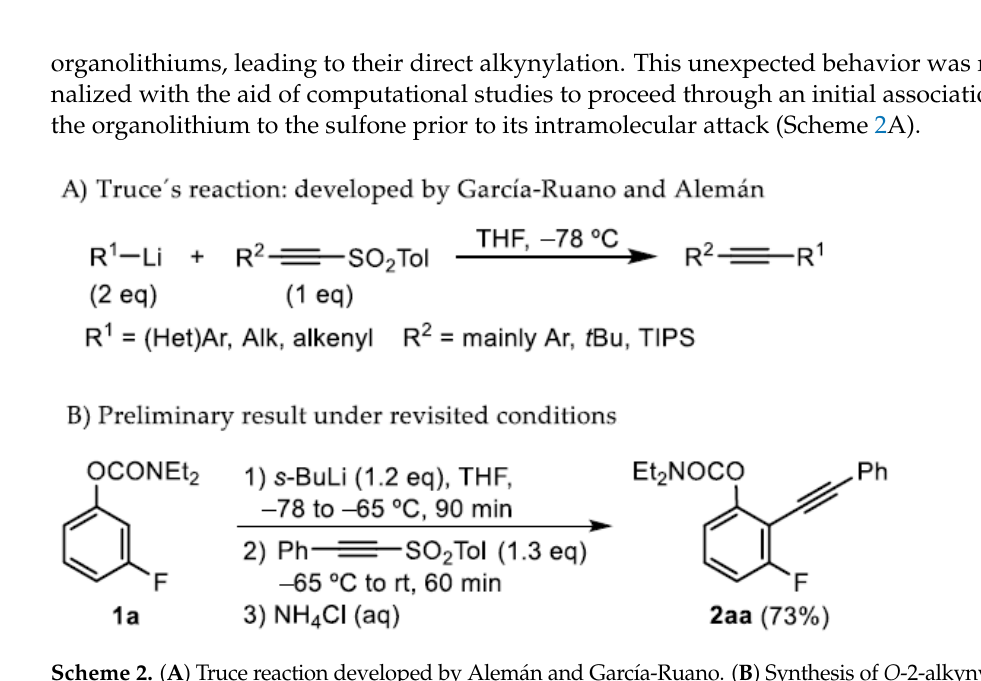
Table 1. Synthesis of O -2-alkynylaryl N,N -diethyl carbamates 2 a .